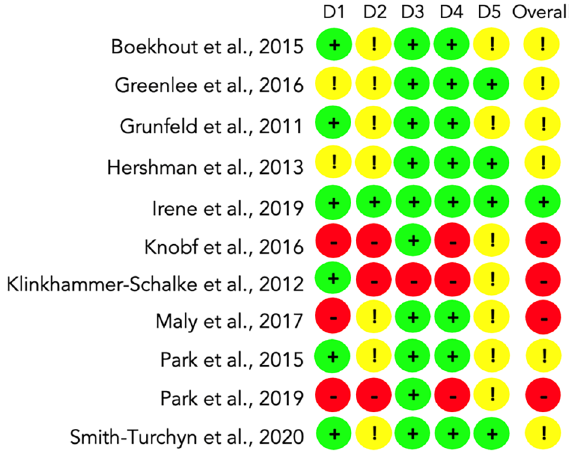
Figure 2. Analysis of the Risk of Bias (RoB2) for all included studies (n=11). D1: Randomisation process. D2: Deviations from the intended interventions. D3: Missing outcome data. D4: Measurement of the outcome. D5: Selection of the reported result. Overall risk of